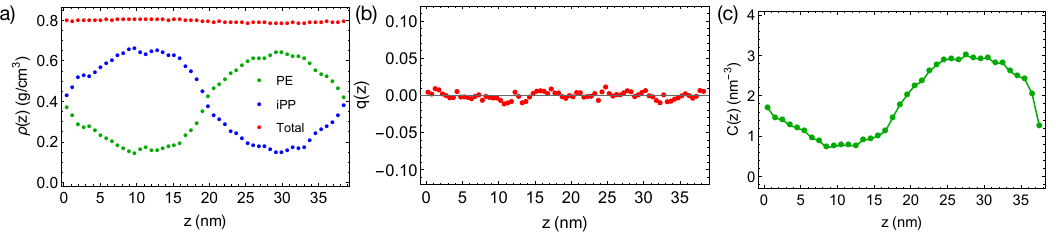
Figure 2. ( a ) Density profiles; ( b ) distribution of nematic order; ( c ) concentration of all-trans PE atoms in the binary blend of PE/iPP oligomers at 400